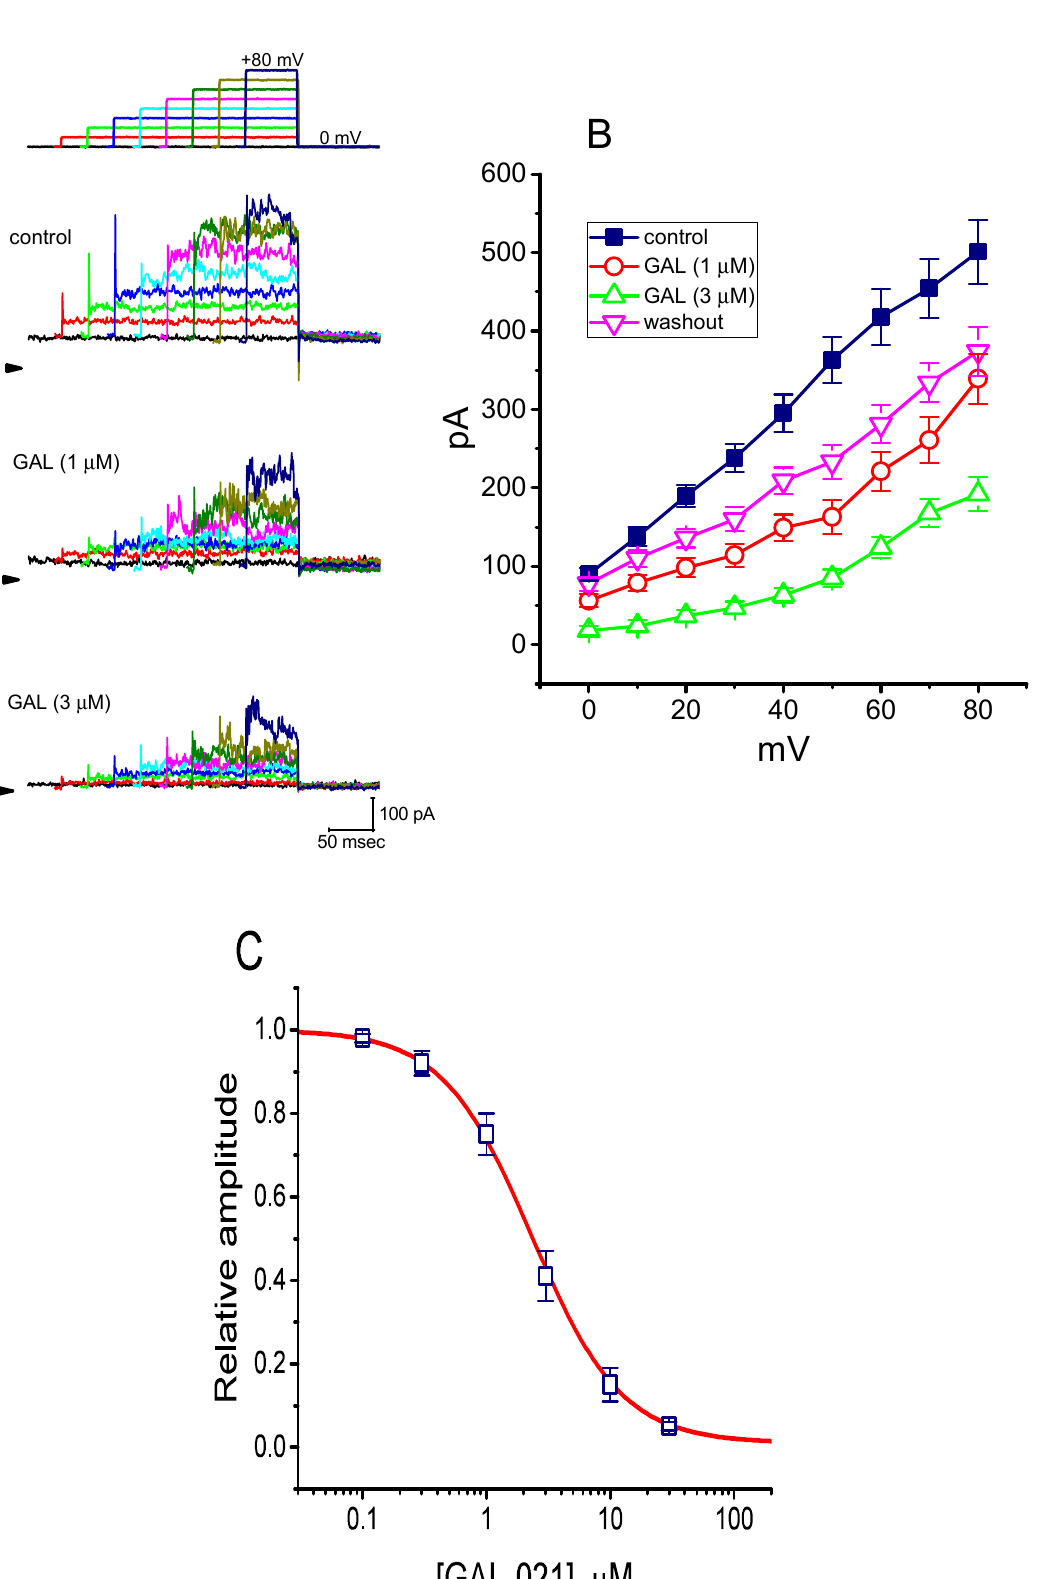
Figure 1. Suppressive effects of GAL-021 on the magnitude of Ca 2+ -activated K + current ( I K(Ca) ) recorded from GH 3 pituitary tumor cells. In this set of whole-cell current recordings, we immersed cells in normal Tyrode’s solution containing 1.8 mM CaCl 2 , and the recording pipette used was filled with a K + -containing solution. Current traces are illustrated under voltage-clamp conditions during voltage pulses from 0 to +80 mV in 10-mV increments from a holding potential of 0 mV. ( A )